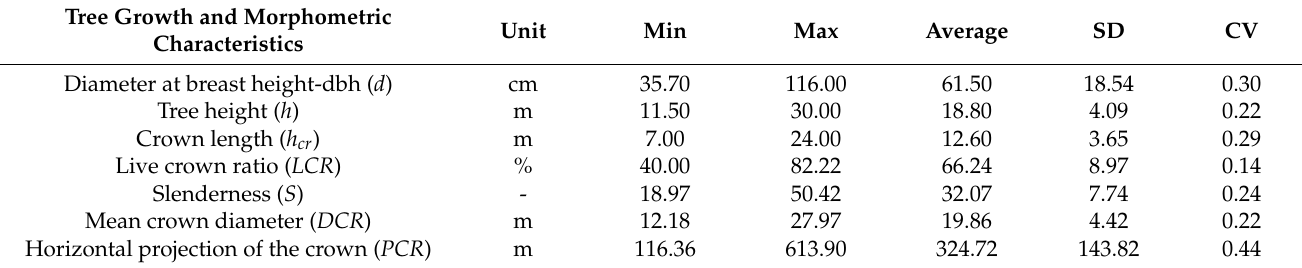
Table 1. Summary of the growth and morphometric characteristic of the rain trees at Darmaga Campus ( n = 50 trees). Tree Growth and